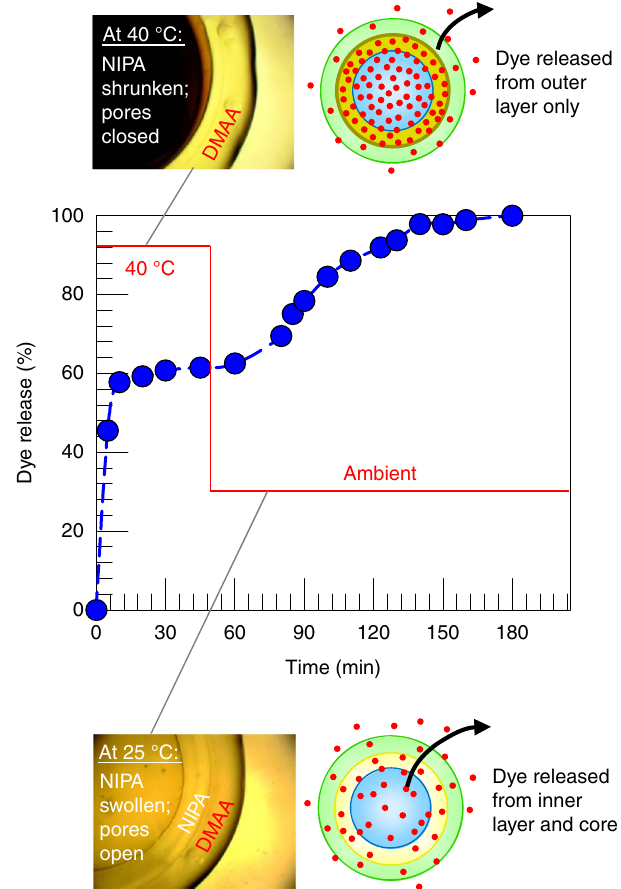
Fig. 7 Temperature-responsive release of dye from a two-layer NIPA – DMAA capsule. Here, NIPA is the inner layer and DMAA is the outer layer. At 40 °C (above the LCST of NIPA), the pores in the inner NIPA layer are closed. In this case, the dye in the outer DMAA layer alone is released, as shown by the schematic. The corresponding micrograph shows a dark inner portion due to the turbidity of the NIPA layer, while the outer layer is transparent. At the 45 min mark, the temperature is lowered to ambient (25 °C). The pores in the NIPA layer open up, causing the inner dye to also release. This is shown by the schematic and in this case the entire capsule is transparent